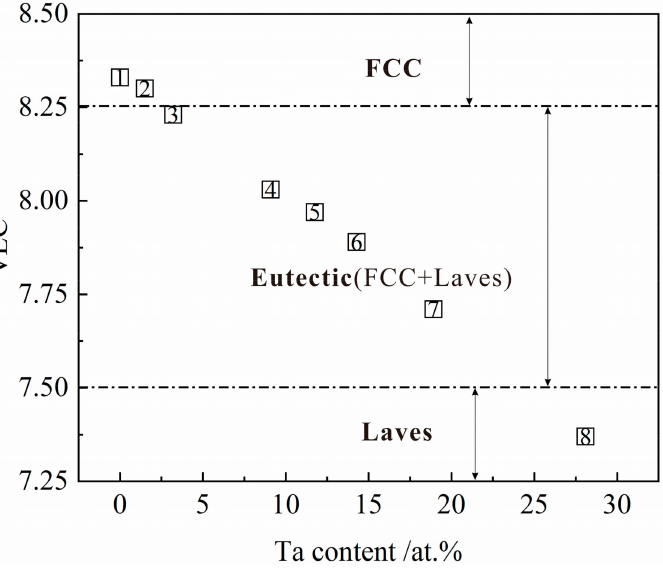
Figure 5. The phase formation of FCC, eutectic, Laves on VEC versus Ta content in CrCoNiTa x